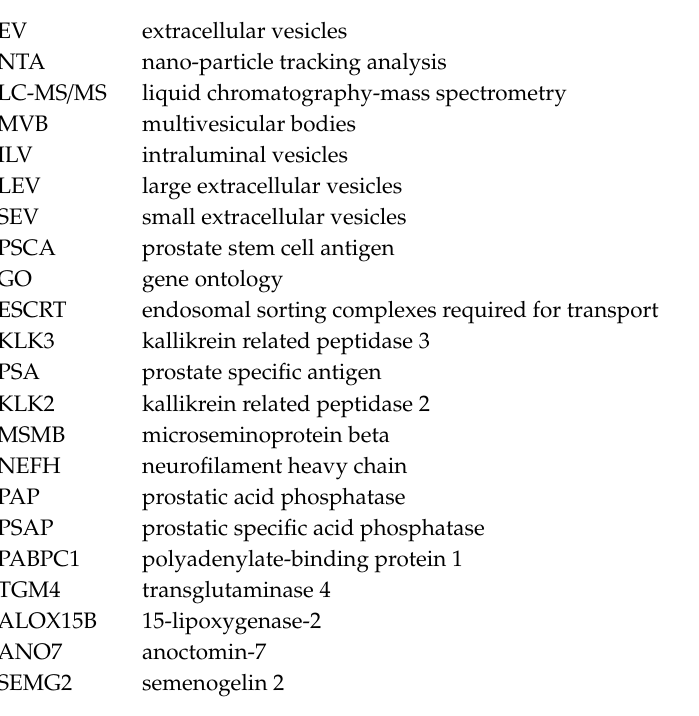
Table S1: Proteins in LEV and SEV isolates detected by LC-MS /